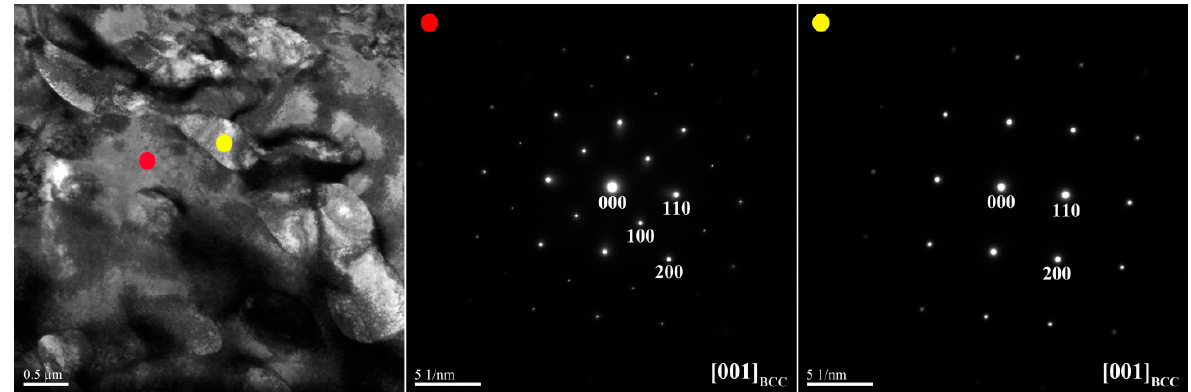
Figure 6. TEM bright-field image and SAED patterns of the dendrite for the X 0.5 as-cast alloy (red dot: ordered BCC; yellow dot: BCC).